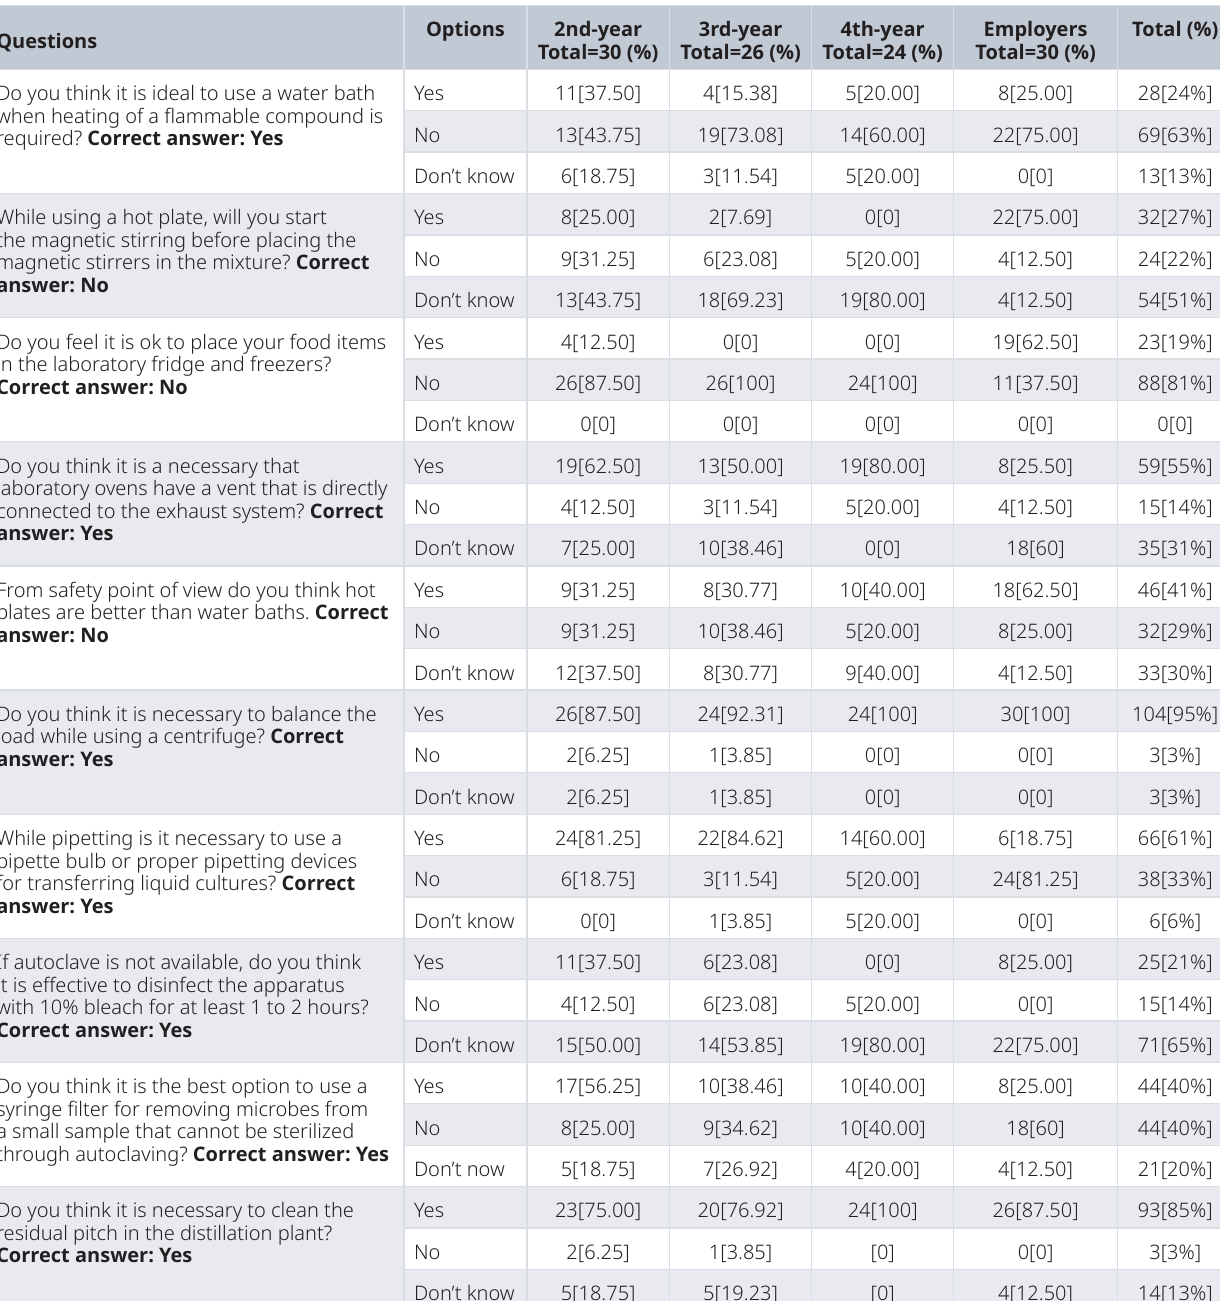
Table 3. Participants’ attitude towards microbiology laboratory